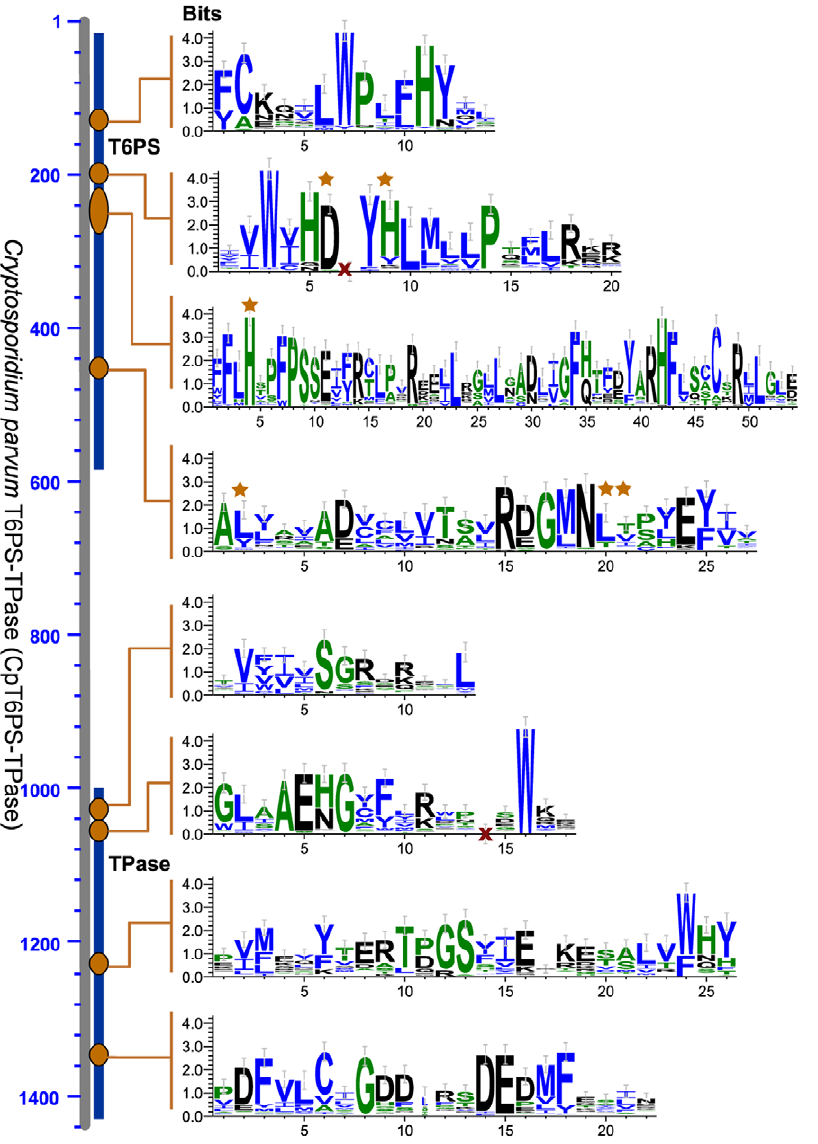
Figure 3. Structure of putative apicomplexan Class II, bifunctional trehalose-6P synthase–trehalose phosphatase (T6PS-TPase) as exemplified by Cryptosporidiumparvum protein (CpT6PS-TPase). Sequence logos corresponding to the T6PS and TPase domains represent conserved motifs determined from 140 orthologs. Stars indicate amino acids important at the active sites.